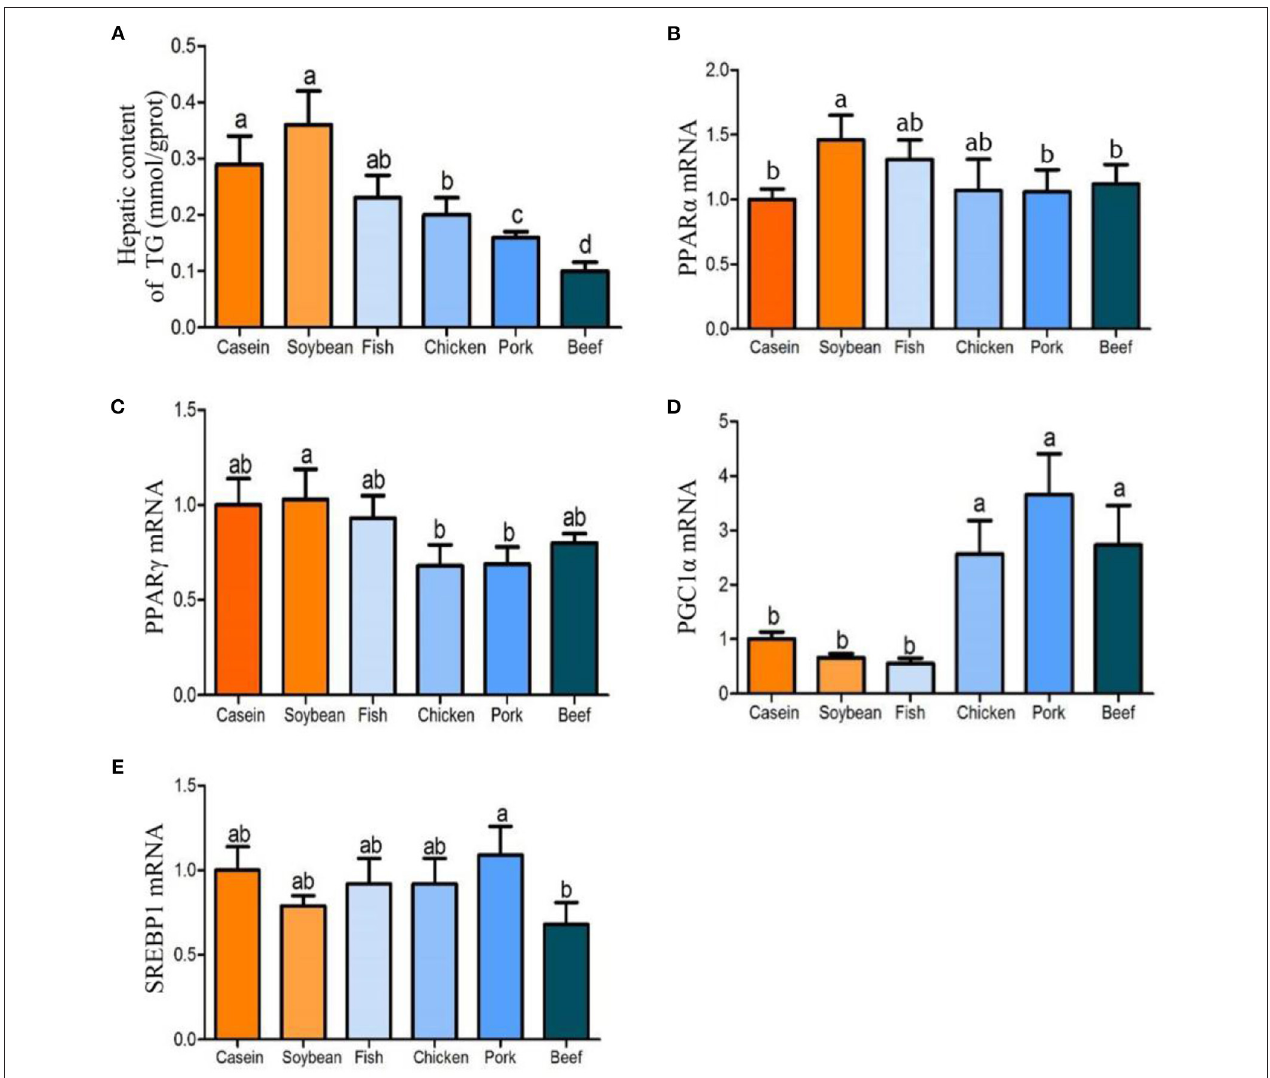
FIGURE 4 | Effect of dietary casein, soy and meat proteins on rat liver lipid metabolic regulation factor related genes. (A) Triglyceride in the liver of rats fed different protein diets. (B–E) qPCR analysis of lipid metabolism related genes. Values are presented as the means ± SD. Groups were compared by one-way ANOVA followed by Duncan’s multiple range tests. Letters a–c represent significant differences between diet groups ( p <